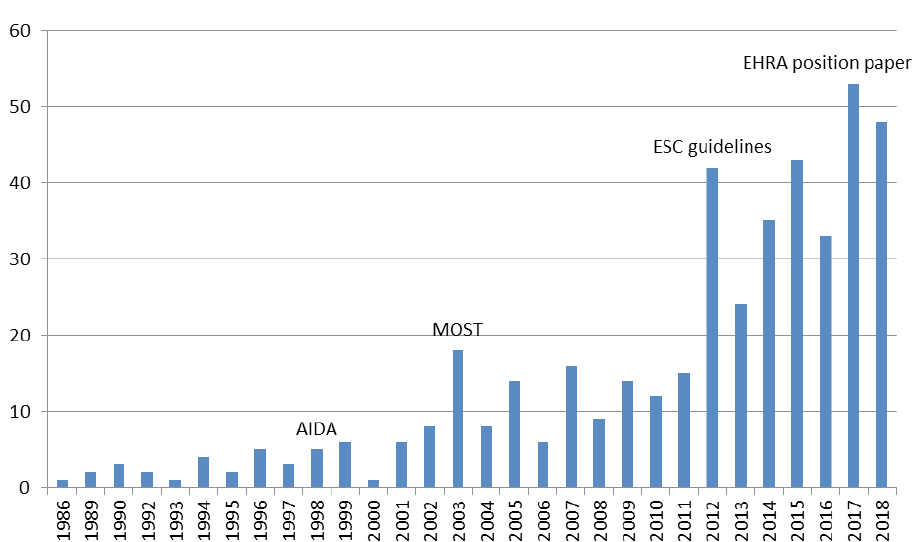
Fig. 1. Evolution of the number of publications related to SCAF, with indication of the milestone studies of subclinical atrial fibrillation as documented by Medline database; best match search –